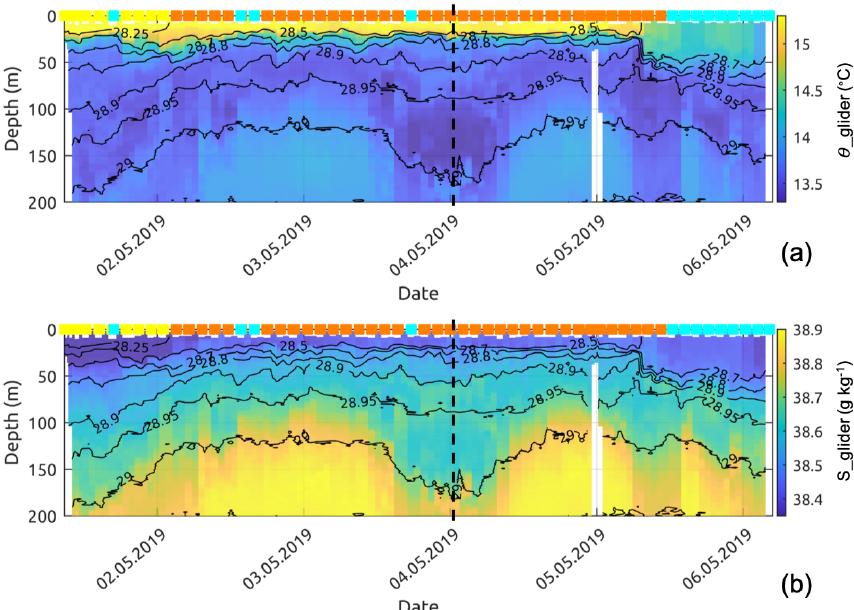
Figure 11. Glider profiles of (a) conservative temperature and (b) absolute salinity. The coloured squares correspond to the dominant water mass (according to Fig. 7) observed at 10m depth by the glider. The dashed vertical line represents the time separating the descending and ascending transects.